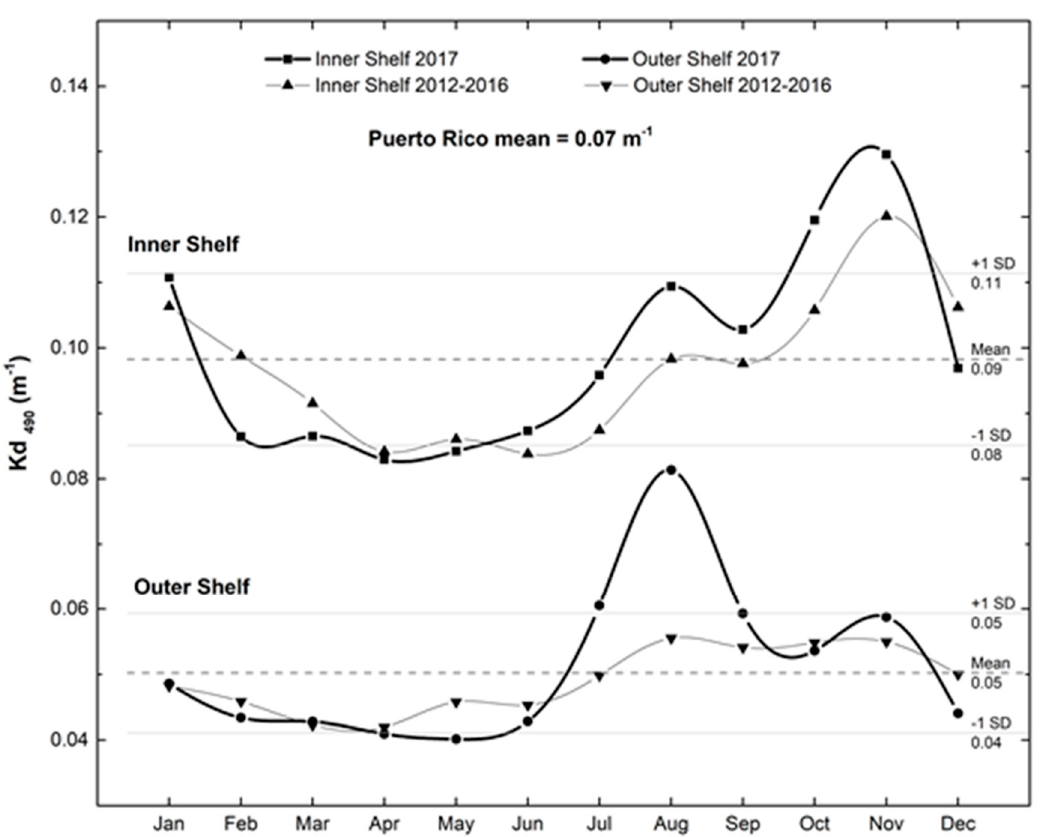
Figure 10. K d 490 for inner shelf and outer shelf of Puerto Rico waters.